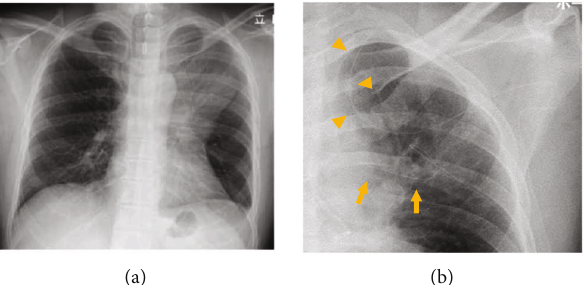
Figure 1: Chest radiography: (a) preoperative chest radiograph demonstrated a mass shadow in the left upper and middle lung fi elds; (b) postoperative chest radiography on the day of surgery showed drains in the neck and chest wall abscesses (arrowheads) and the retrosternal and extrapleural abscesses